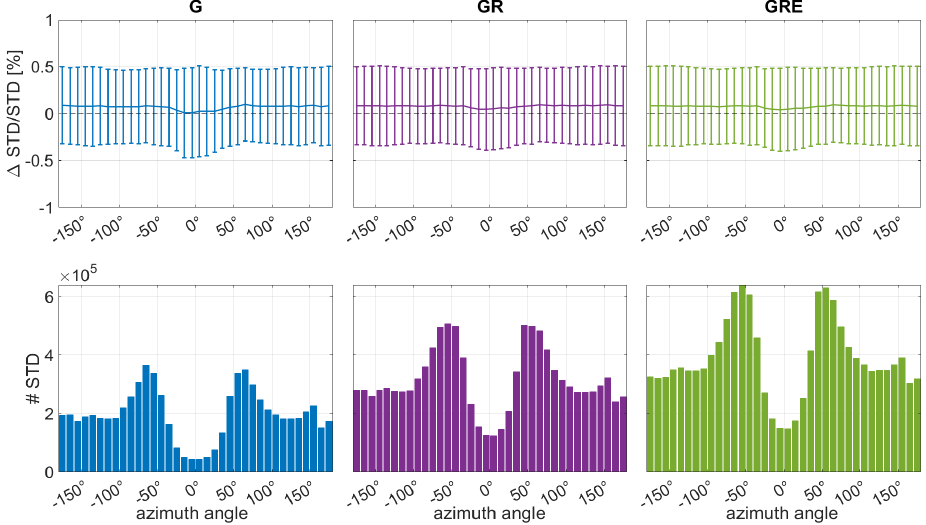
Figure 16. The STD relative differences between ERA5 and the three different GNSS solutions: GPS-only, GR and GRE (top panels) and the number of observations with respect to the azimuth angle for each solution (bottom). The differences are calculated for the entire year